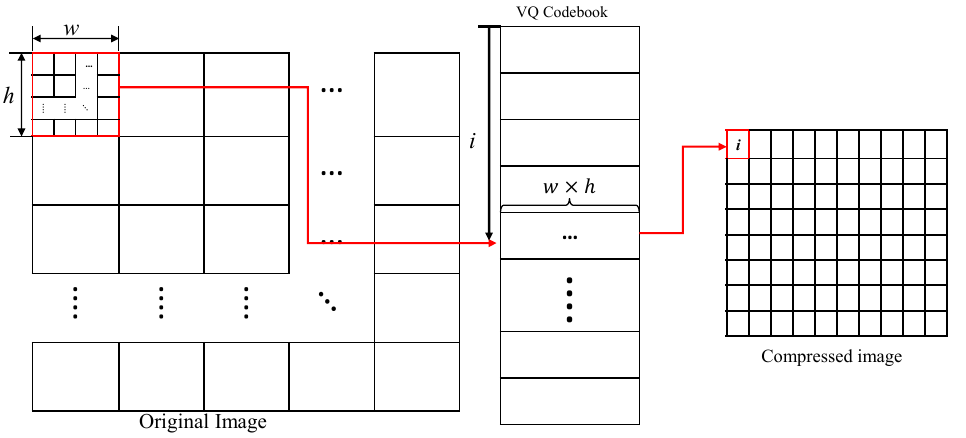
Figure 2. The encoding method of VQ.